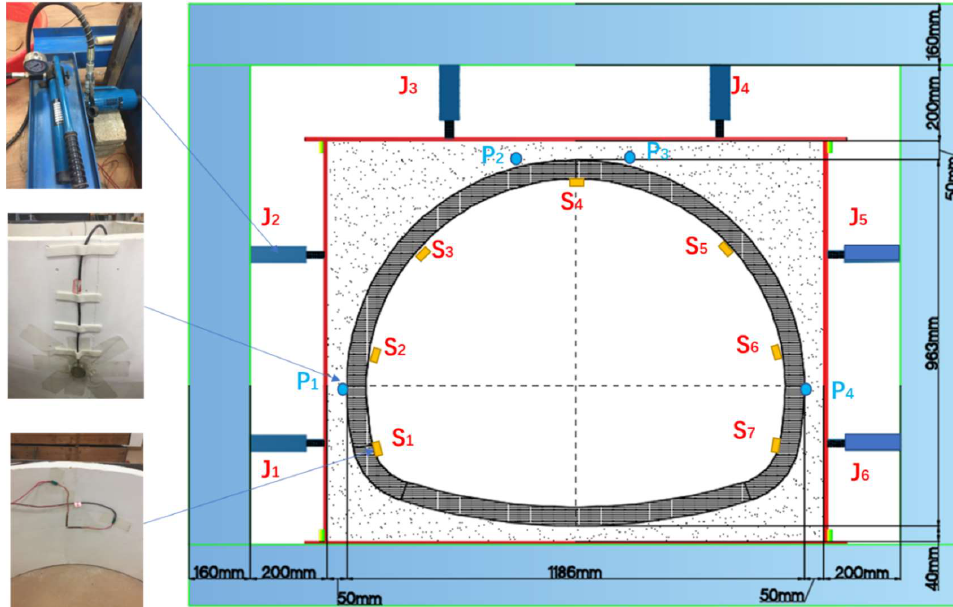
Figure 4. Schematic diagram of the test platform.